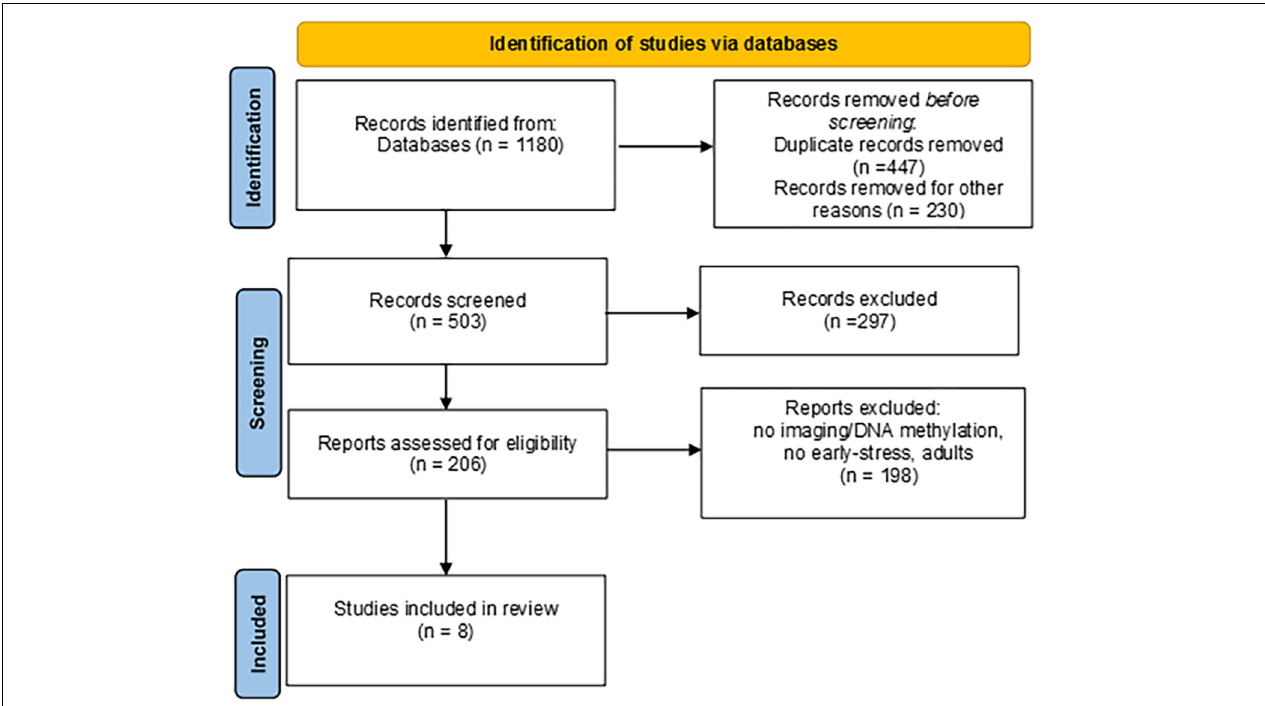
FIGURE 1 | PRISMA flow diagram.